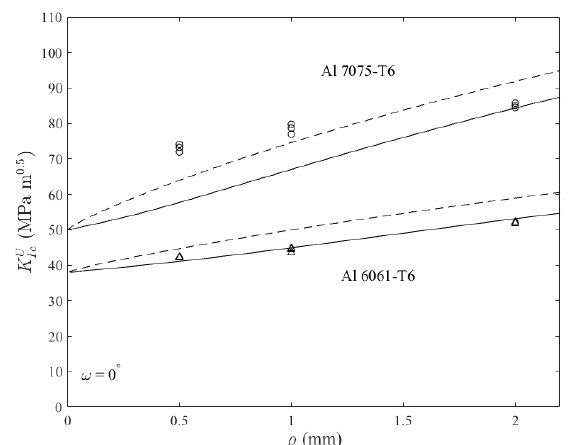
Figure 2. U-notched structures ( ω = 0 ◦ ), apparent fracture toughness: Predictions by punctual FFM (dashed line) and average FFM (continuous line) related to experimental data on Al 7075-T6 plates (circles) and on Al 6061-T6 plates (triangles).